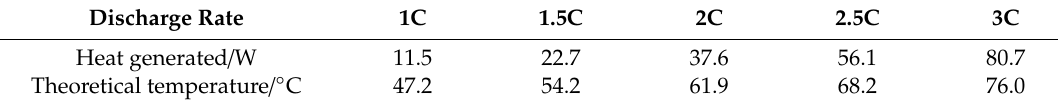
Table 3. Lithium ion battery heat production and theoretical temperature.